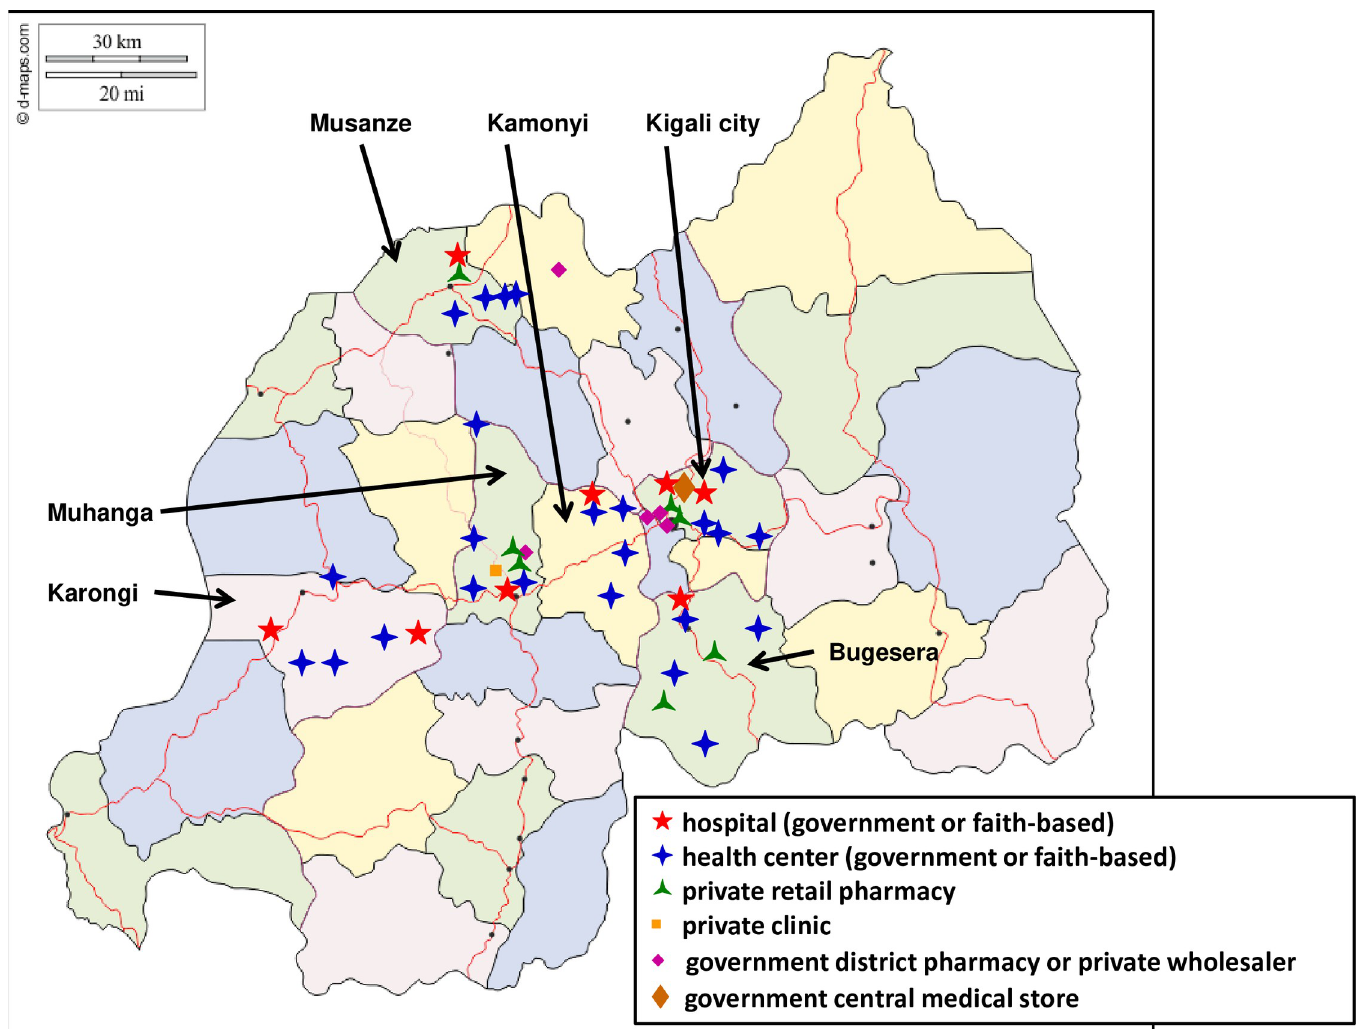
Fig 2. Map of the location of the 46 facilities from which oxytocics were collected. Reprinted (with modifications) from https://d-maps.com/conditions.php?lang=en under a CC BY license, with permission from d-maps.com, original copyright 2007–2020.